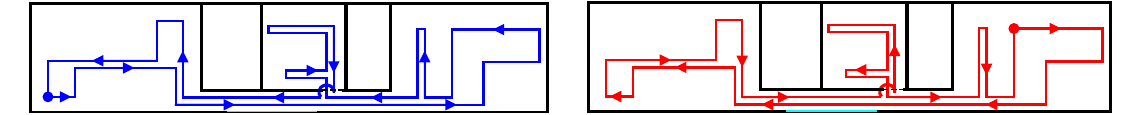
Figure 10. Trajectories of in-motion RSSI captures: for calibration ( left ) and for tracking ( right ).